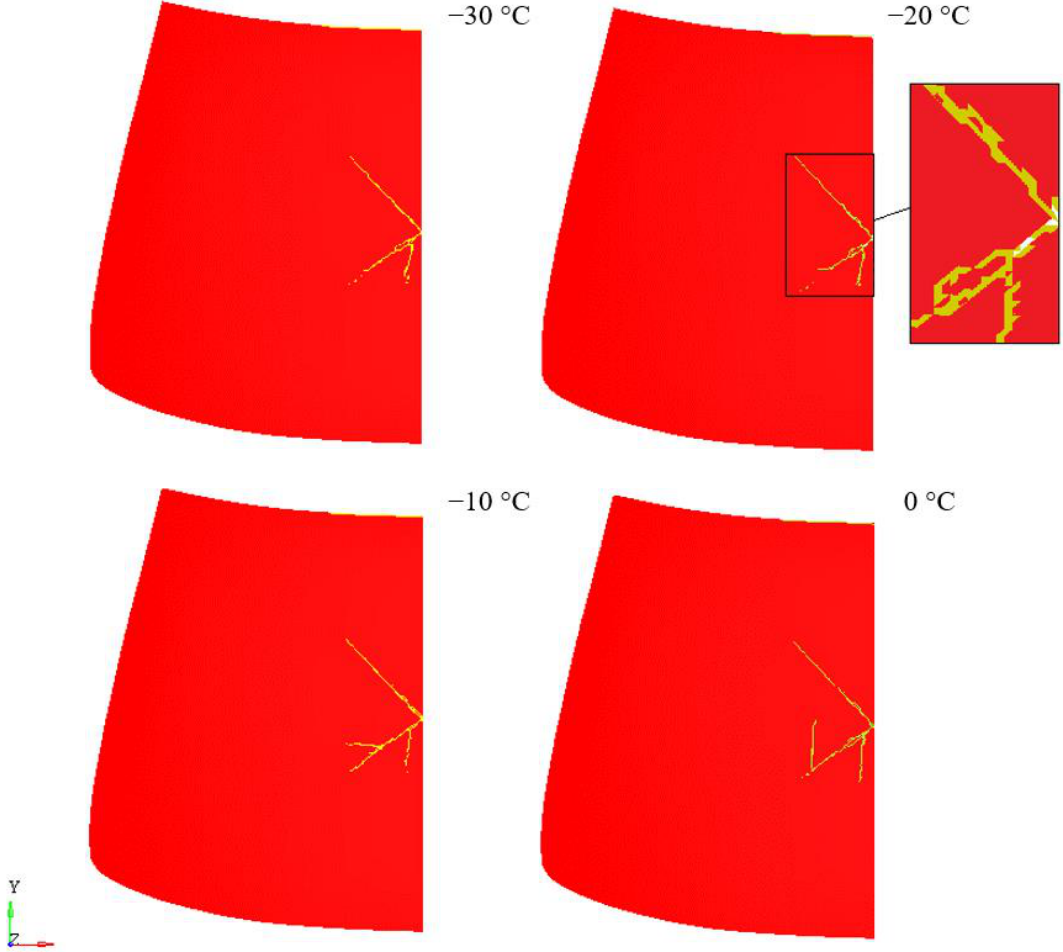
Figure 13. Laminate damage — no heating.